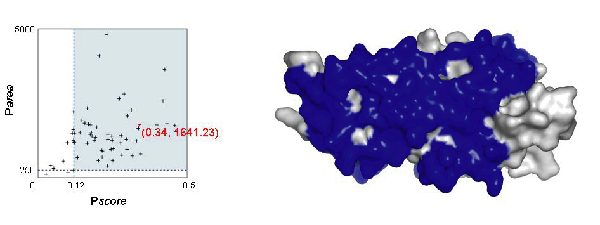
left side: graphical representation of the statistical parameters (Pscore and Parea, see [30]) on which the prediction of DNA-binding site is based. Black crosses indicate the Pscore and Parea values calculated for 63 representative dsDNA-binding proteins, while red asterisk refers to the values of the same parameters for the viral histone pseudodimer. Only proteins with Pscore > 0.12 and Parea > 250 (thus included in the upper right region of the graph) are considered dsDNA-binding proteins. Right side: localization of the predicted DNA-binding surface (in blue) on the viral histone pseudodimer model.